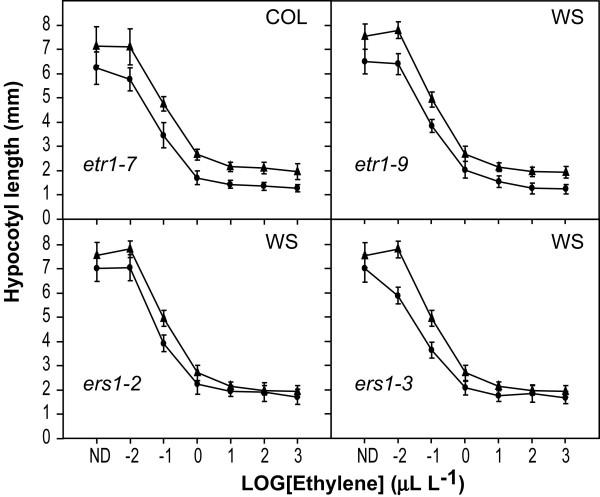
Ethylene dose-response analysis for etr1 and ers1 single mutants. The etr1-7 mutant is of ecotype Columbia (COL). The etr1-9, ers1-2, and ers1-3 mutants are of the ecotype Wassilewskija (WS). The response of the hypocotyl length to ethylene is shown for the mutants (black circles), with the appropriate wild-type control included for comparison (black triangles). Values represent the means with standard deviation for at least 25 measurements. ND, No detectable ethylene. AVG (5 μM) was included in growth media to inhibit ethylene biosynthesis by the seedlings.